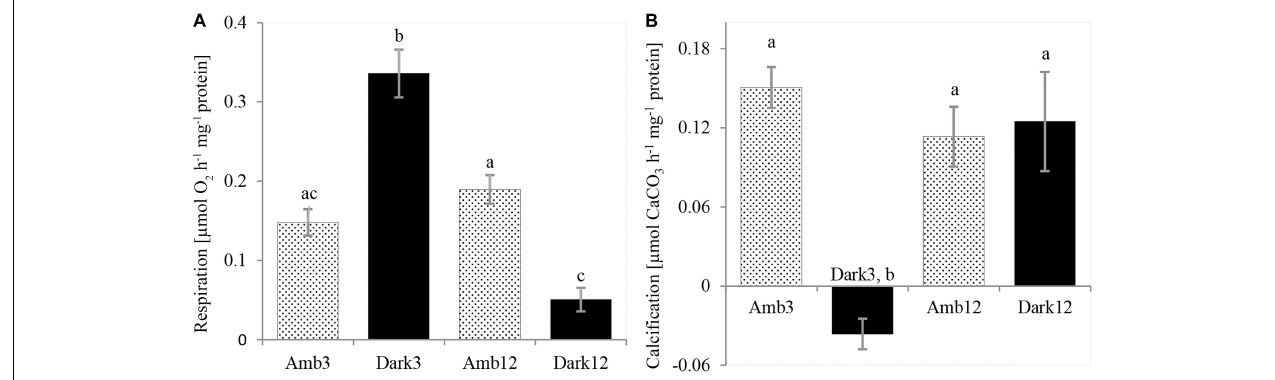
FIGURE 4 | O. patagonica physiology rates. O. patagonica Mean ( ± SE) dark respiration rate (A) and calcification rate (B) of the different samples ( N = 3 per timepoint). Different lowercase letters indicate significantly different samples (see Table 2 for exact values).